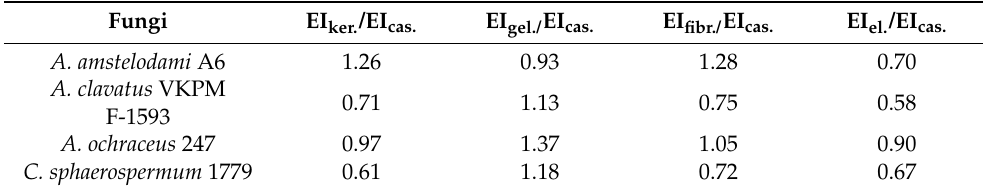
Table 3. Ratios of enzymatic indices of A. amstelodami A6, A. clavatus VKPM F-1593, A. ochraceus 247, and Cladosporium sphaerospermum